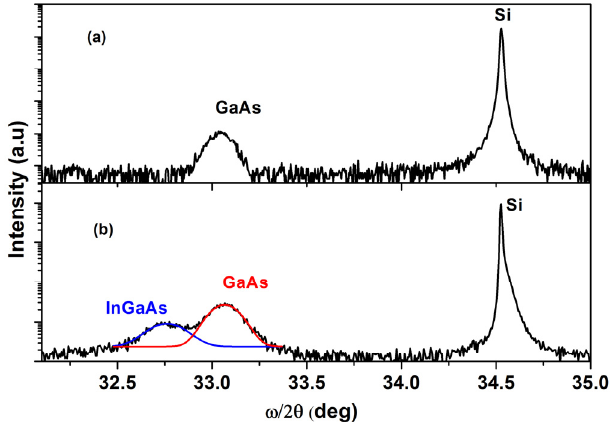
Figure 3. The ω /2 θ of reflection peak of: ( a ) pin-GaAs/ Si; ( b ) pin-GaAs/Si with InAs/InGaAs multilayer